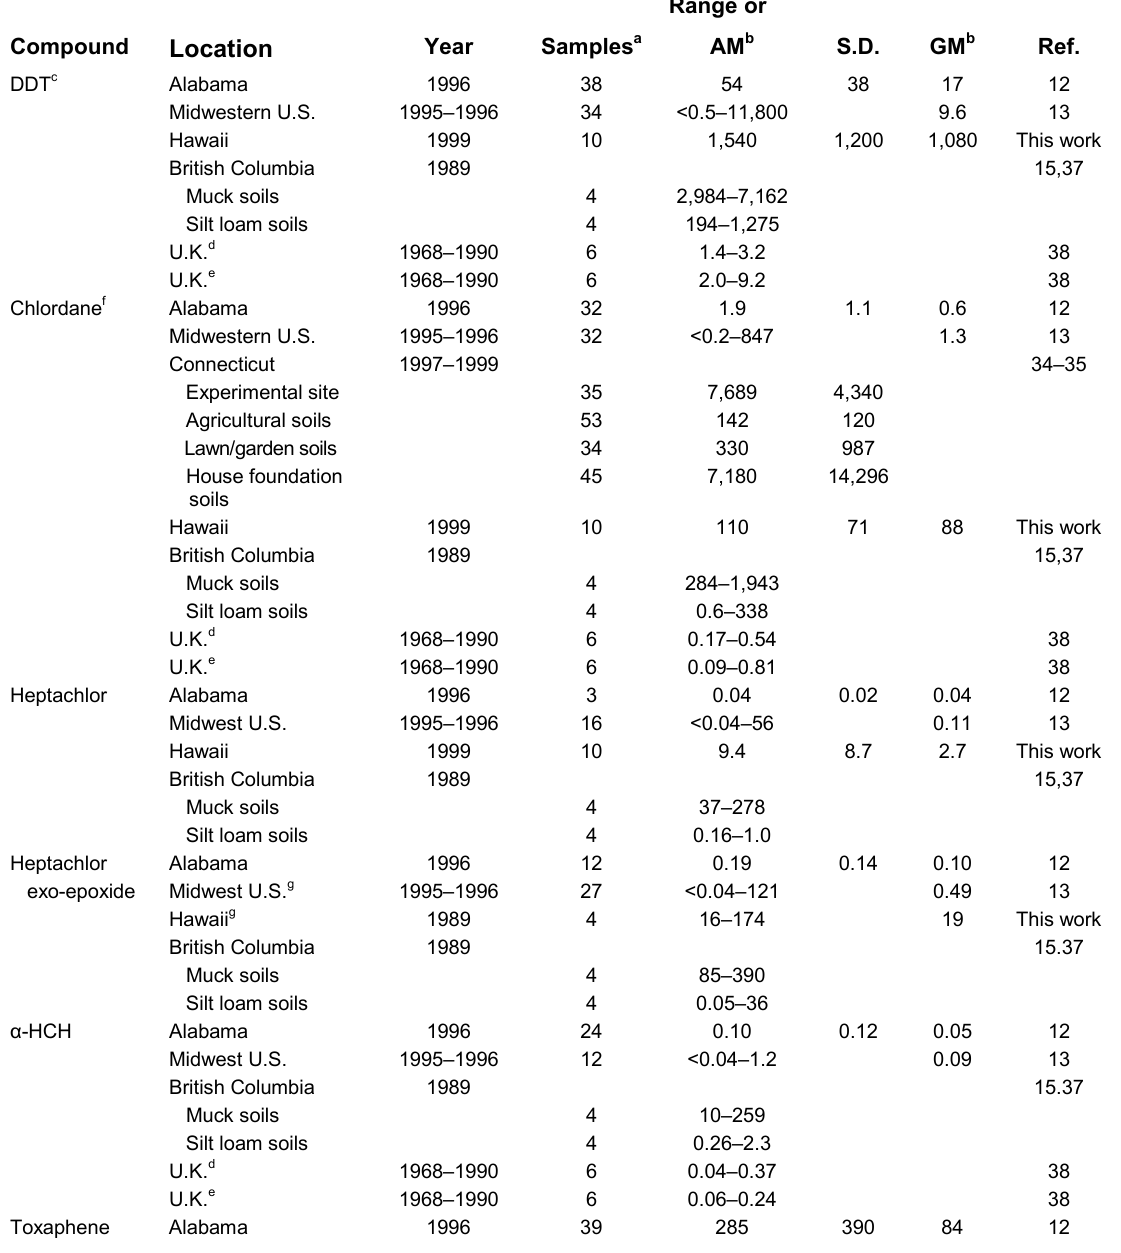
Chiral Organochlorine Pesticides in Soils, ng/g Dry